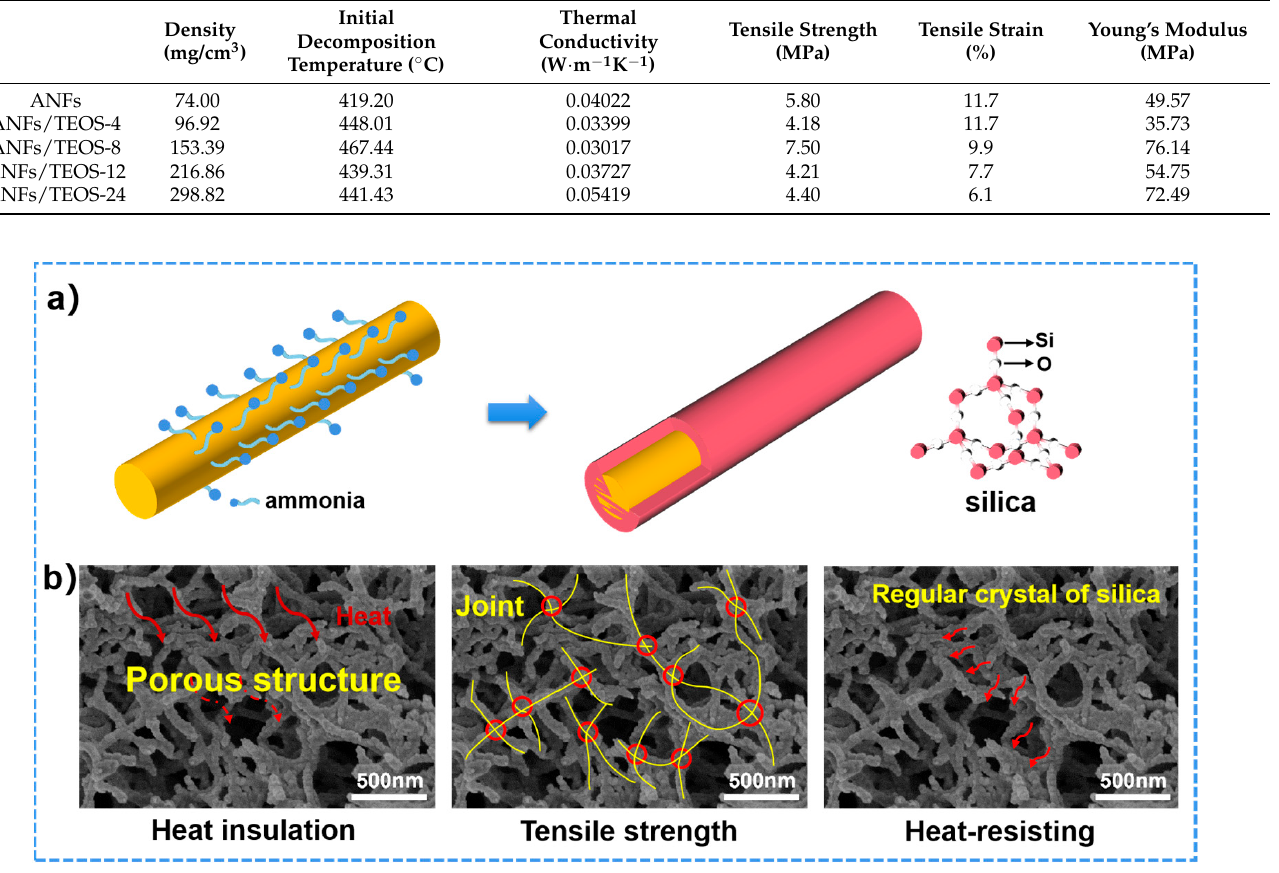
Table 1. Density, initial decomposition temperature, thermal conductivity, tensile strength, and Young’s modulus of ANFs and ANFs/TEOS aerogels.